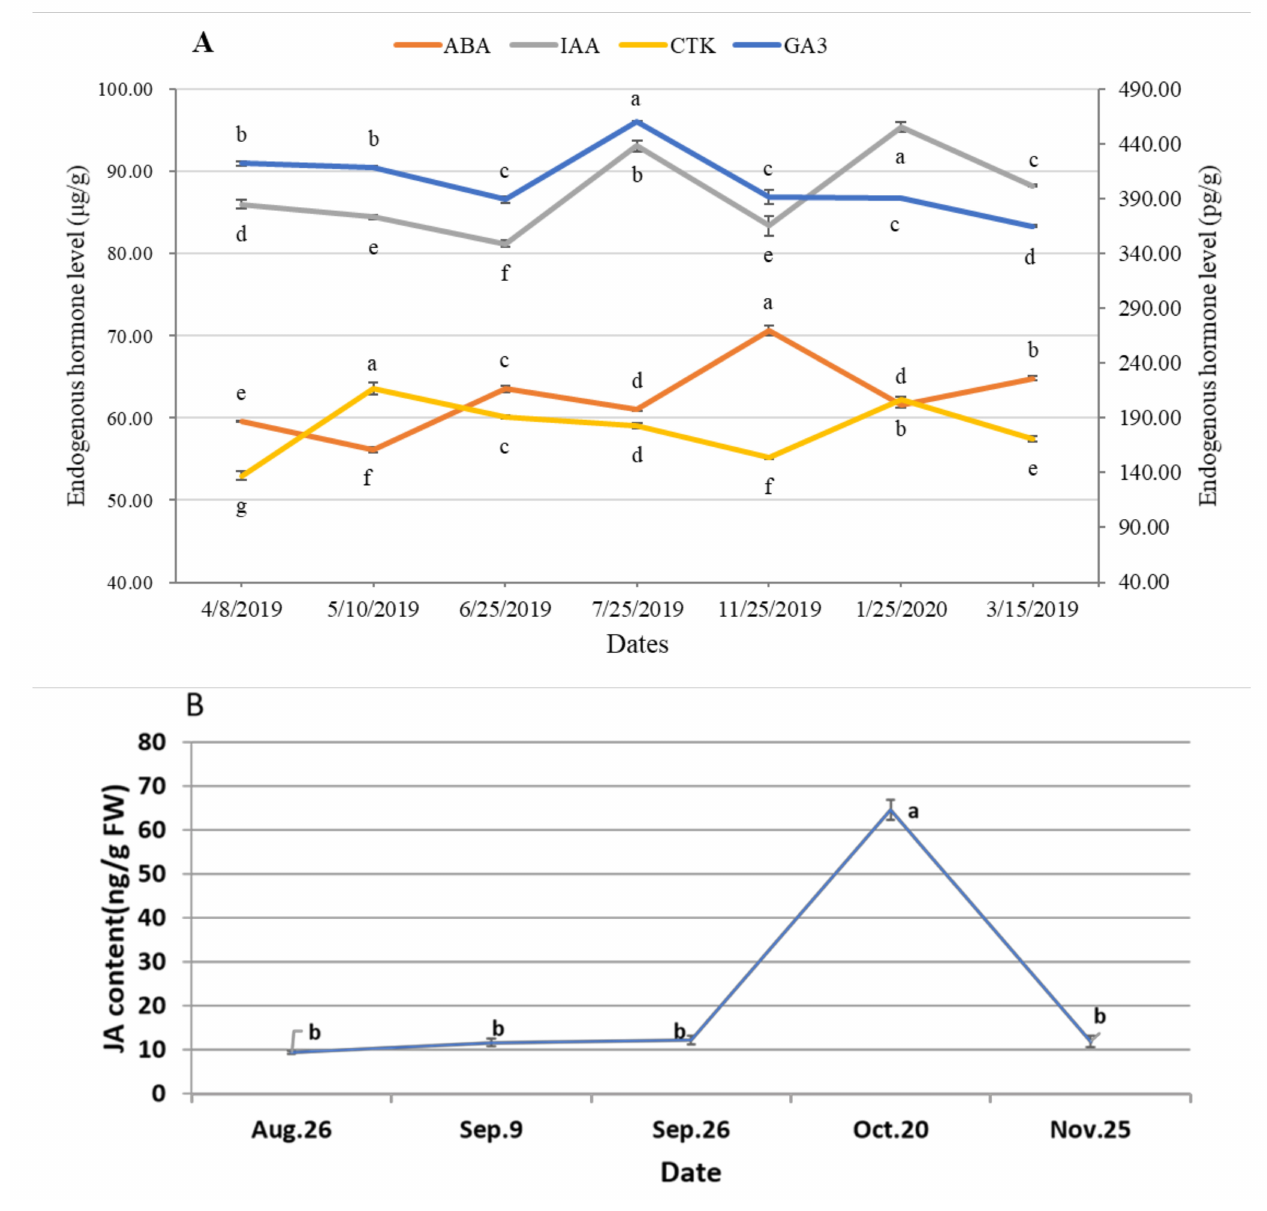
Figure 4. Endogenous hormone changes in D. pectinatum male cones at different developmental stages. ( A ) Hormones analyzed by ELISA. The unit of GA 3 was pg/g fresh weight (left vertical axis). The unit for ABA, IAA, and CTK was µ g/g fresh weight (right vertical axis). ( B ) JA was detected by ultra-high-performance liquid chromatography in combination with a tandem mass spectrometry. The error bars represent standard deviation. Different letters indicate significant difference at p < 0.05, n =